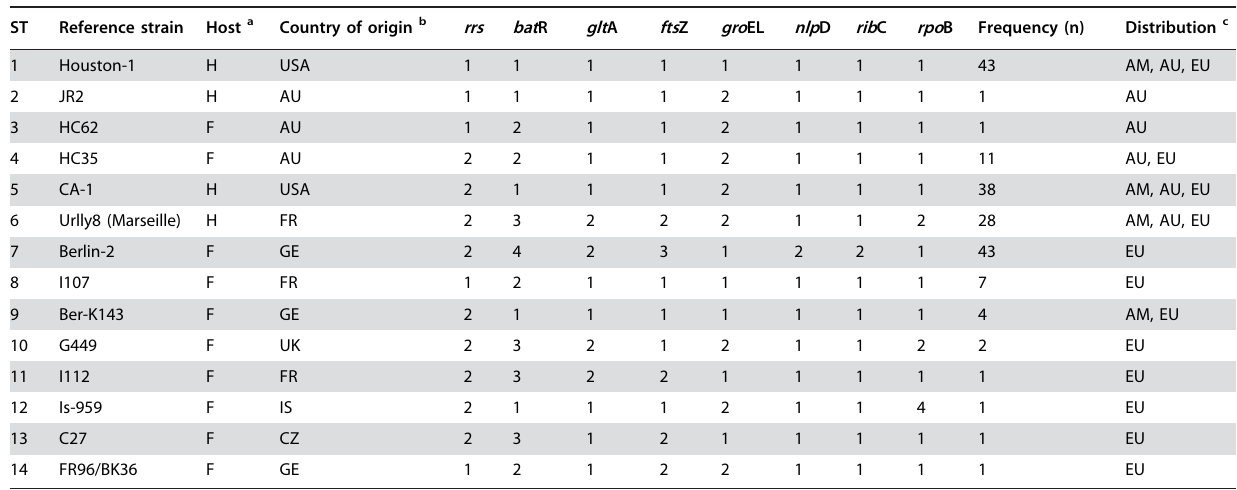
Table 1. Allelic profile, frequency of isolation, and geographic distribution of STs. .. ... .... ... ... .... ... ... .... ... ... .... ... ... .... ... ... .... ... ... .... ... ... .... ... ... .... ... ... .... ... ... .... ... ... .... ... ... .... ... ... .... ... ... . ST Reference strain Host